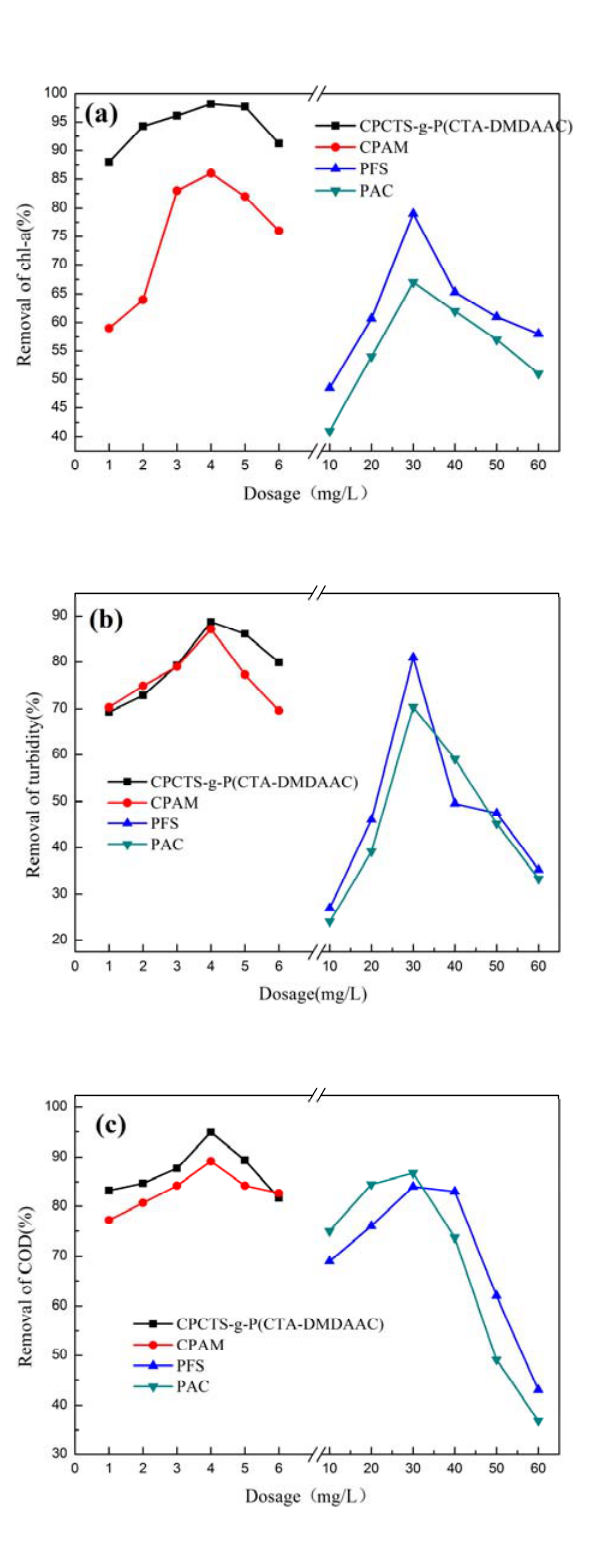
Figure 6. Effect of CPCTS ‐ g ‐ P (CTA ‐ DMDAAC) dosage on flocculation properties: ( a ) chlorophyll ‐ a (Chl ‐ a); ( b ) turbidity; ( c ) chemical oxygen demand (COD). (Chl-a); ( b ) turbidity; ( c ) chemical oxygen demand